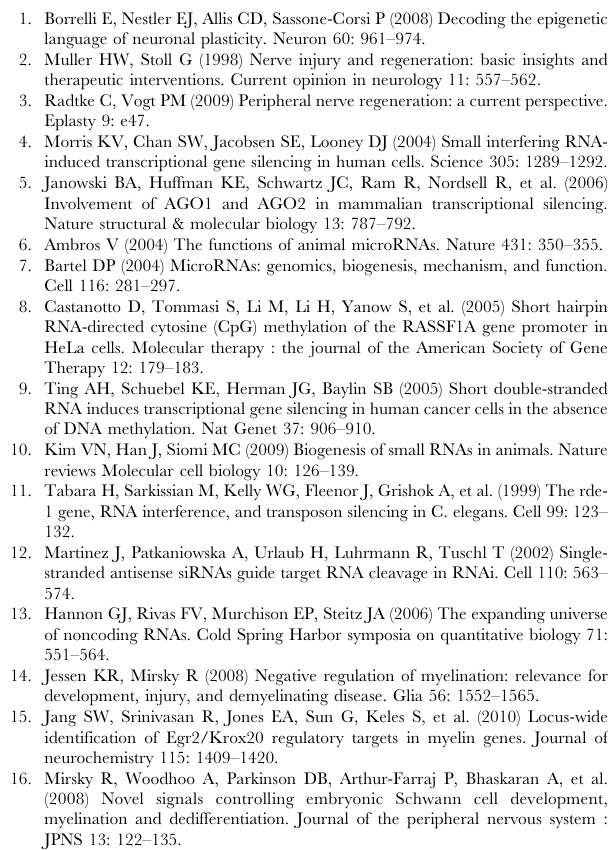
Table S1 Accessibility analysis for miRNA binding sites in various gene targets using STarMir. Table S2 Accessibility analysis for miRNA binding sites in Luciferase constructs for Egr2, Sox2 and c-Jun using